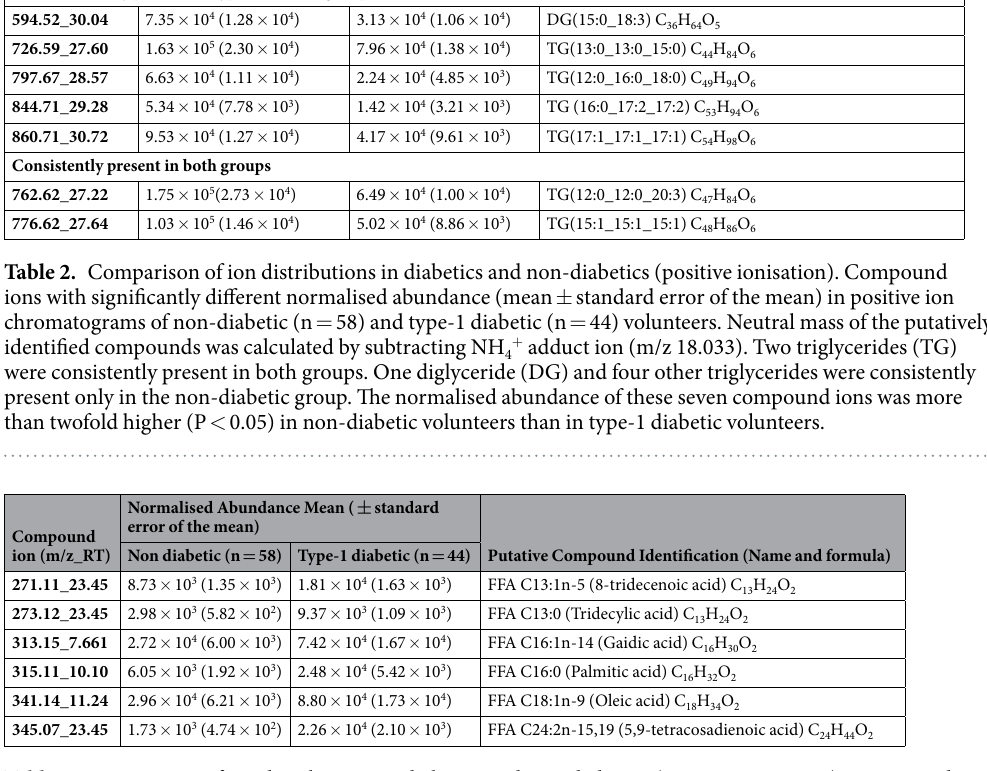
FFA C24:2n-15,19 (5,9-tetracosadienoic acid) C 24 H 44 O 2 Table 3. Comparison of ion distributions in diabetics and non-diabetics (negative ionisation). Compound ions with significantly different normalised abundance (mean ± standard error of the mean) in negative ion chromatograms of non-diabetic (n = 58) and type-1 diabetic (n = 44) volunteers. Neutral mass of the putatively identified compounds was calculated by addition of OAc − adduct (m/z 59.01), except for compound 345.07_23.45, which had the mass of H 2 O-H adduct (m/z 19.02) applied. All six free fatty acids (FFA) were consistently present in type-1 diabetic volunteers and their normalised abundance was more than twofold higher (P < 0.05) in type-1 diabetic volunteers than in non-diabetic